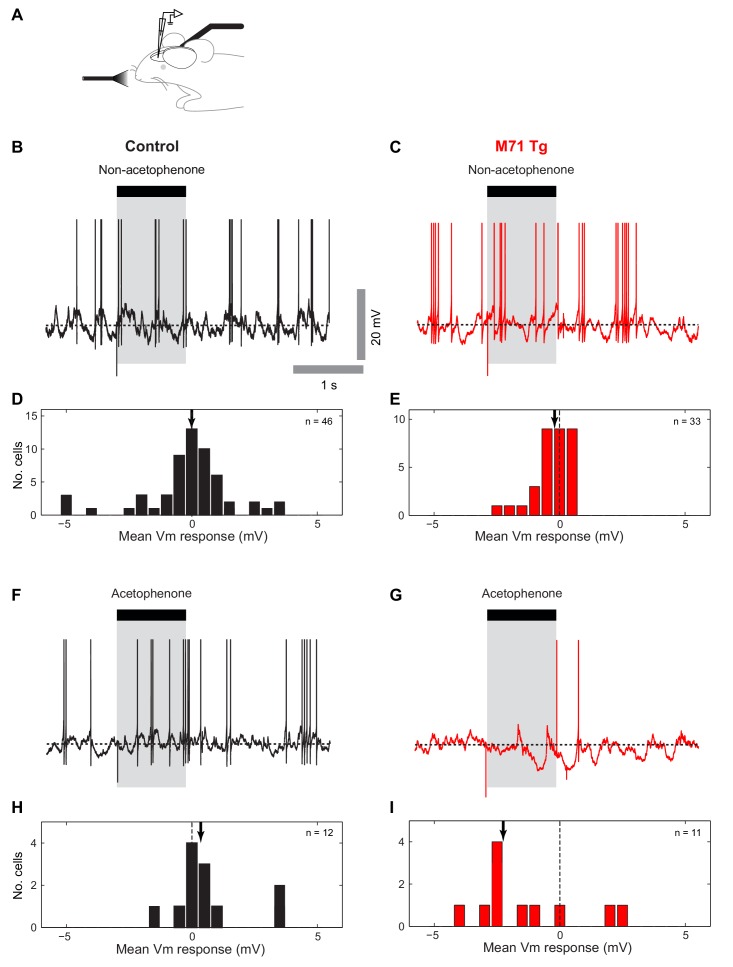
Patch clamp mitral cell recordings in anesthetized mice reveal increased acetophenone-evoked inhibition in M71 transgenic mice.(A) Schematic: whole cell recordings in anesthetized mice. (B, C) Example traces showing single 1 s ethyl acetate presentations (shaded area) during mitral cell recordings from control (black) and M71 transgenic (red) mice. (D, E) Histograms of mean odor-evoked membrane potential responses in control and M71 transgenic cells. (F, G) Example traces showing single 1 s acetophenone presentations during mitral cell recordings from control and M71 transgenic mice. (H, I) Histograms of mean acetophenone-evoked membrane potential responses in control and M71 transgenic cells. Arrows indicate the median evoked Vm.